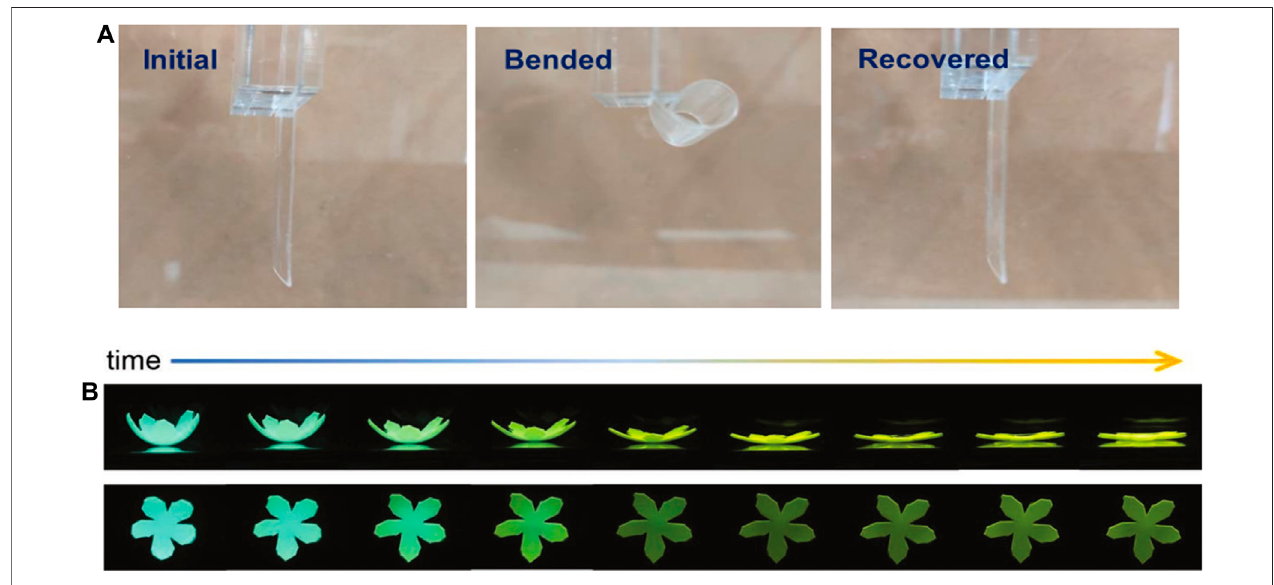
FIGURE 7 | (A) Curling and recovery process of the PDMS fi lm. Reproduced from Zheng et al. (2019) with permission of American Chemical Society. (B) Simultaneous emission change and complex shape deformation of hydrogel actuator. Reproduced from Hubbard et al. (2019) with permission of WILEY-VCH.